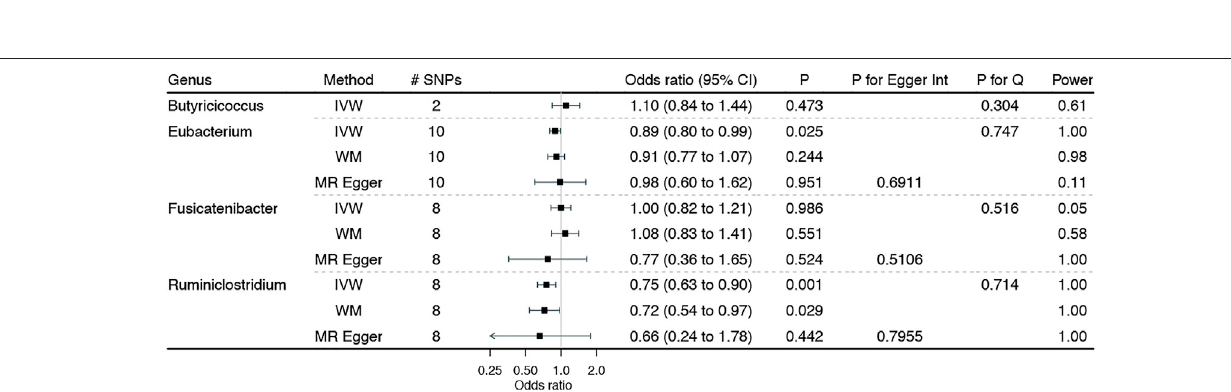
le 1: Supplementary Table S4 . Genetically predicted higher